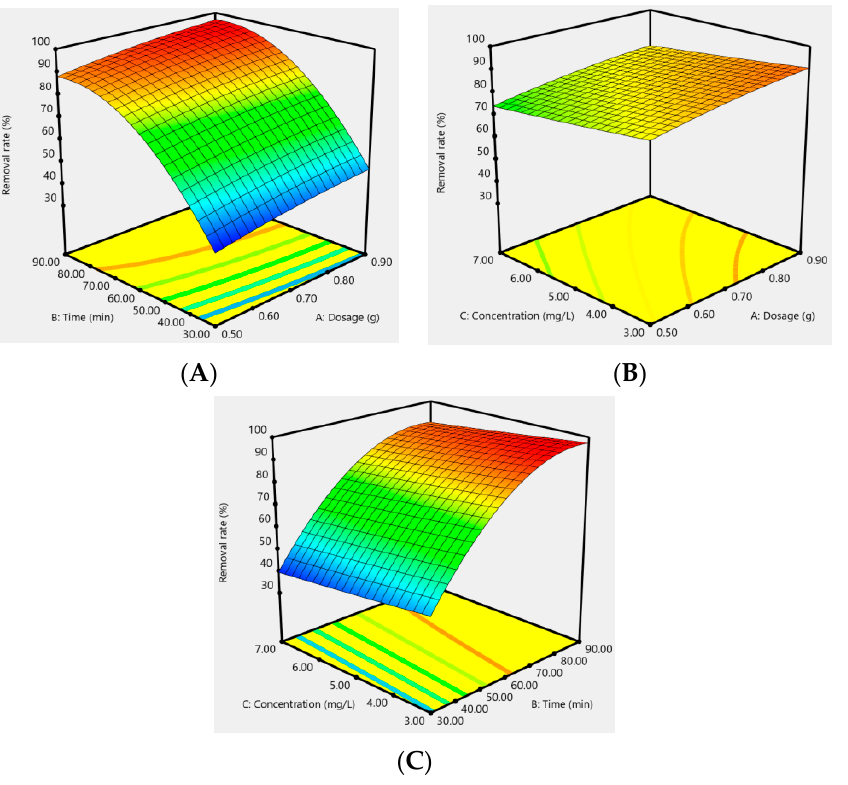
Figure 14. Response surface of the dosage ( A ), contact time ( B ), and concentration ( C ) of AC-TiO 2 on the removal effect of methylene blue.